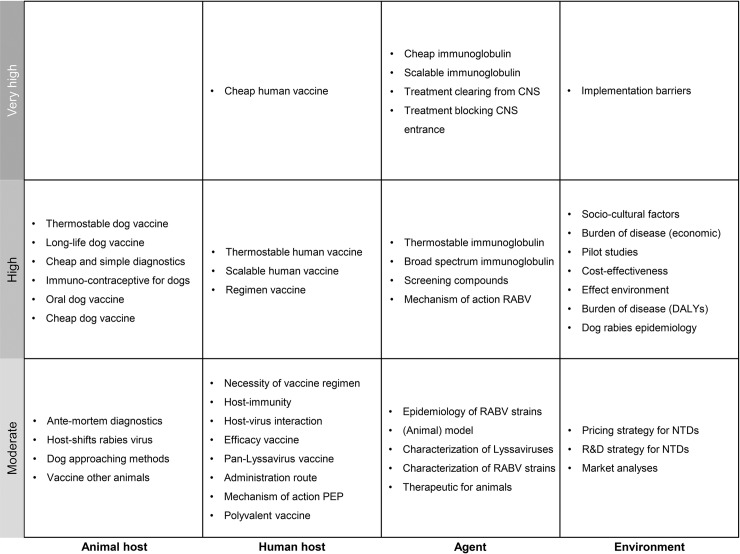
Research needs prioritized for need for improvement.A total of 125 KOLs assessed the research needs of their expertise: animal host (n = 96); human host (n = 88); agent (n = 83); environment (n = 78). Priority groups correspond to scores of 41–60 (moderate), 61–80 (high) and 81–100 (very high). Full descriptions of research priorities and scores can be found in S1 Table. CNS = central nervous system; RABV = rabies virus; R&D = research and development; DALYs = disability adjusted life years; PEP = post-exposure prophylaxes; NTD = neglected tropical disease.